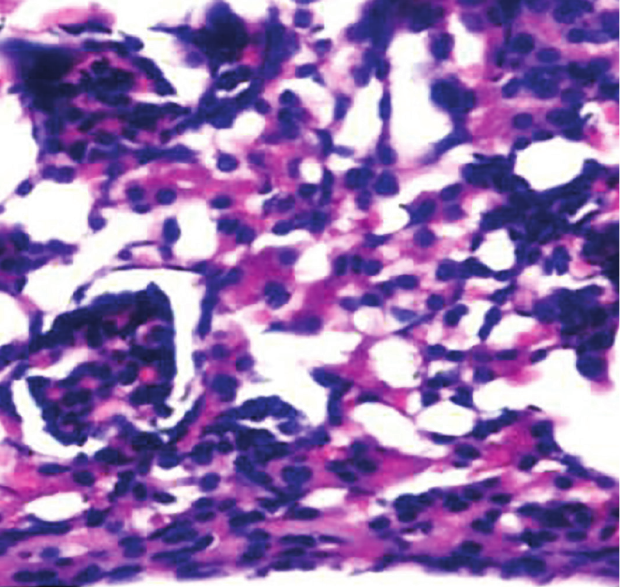
FIGURE 2(B) - Photomicrograph of section of kidney of neonate of pregnant rat (control) showing normal structure. (H & E 400X).